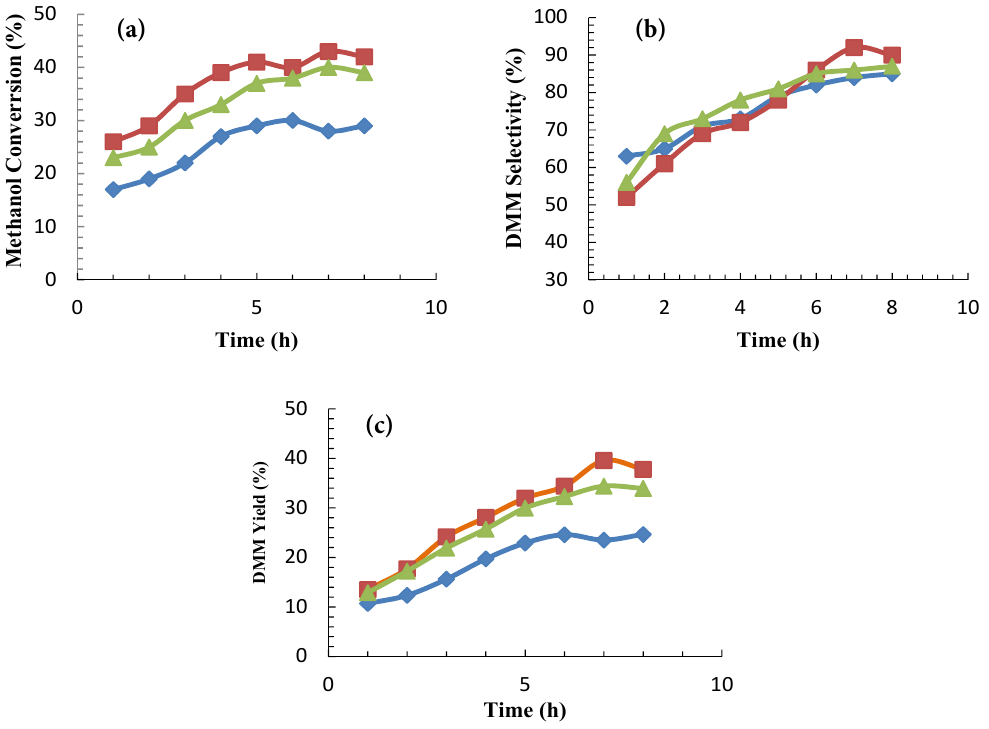
Fig. 5: Effect of reaction time on (a) methanol conversion, (b) DMM selectivity and (c) and DMM yield over Fe-MoI ( ), Fe-MoII ( ) and Fe-MoIII ( ) catalysts. Experimental conditions: GHSV = 16 NLh −1 g −1 , T = 543 K, CH